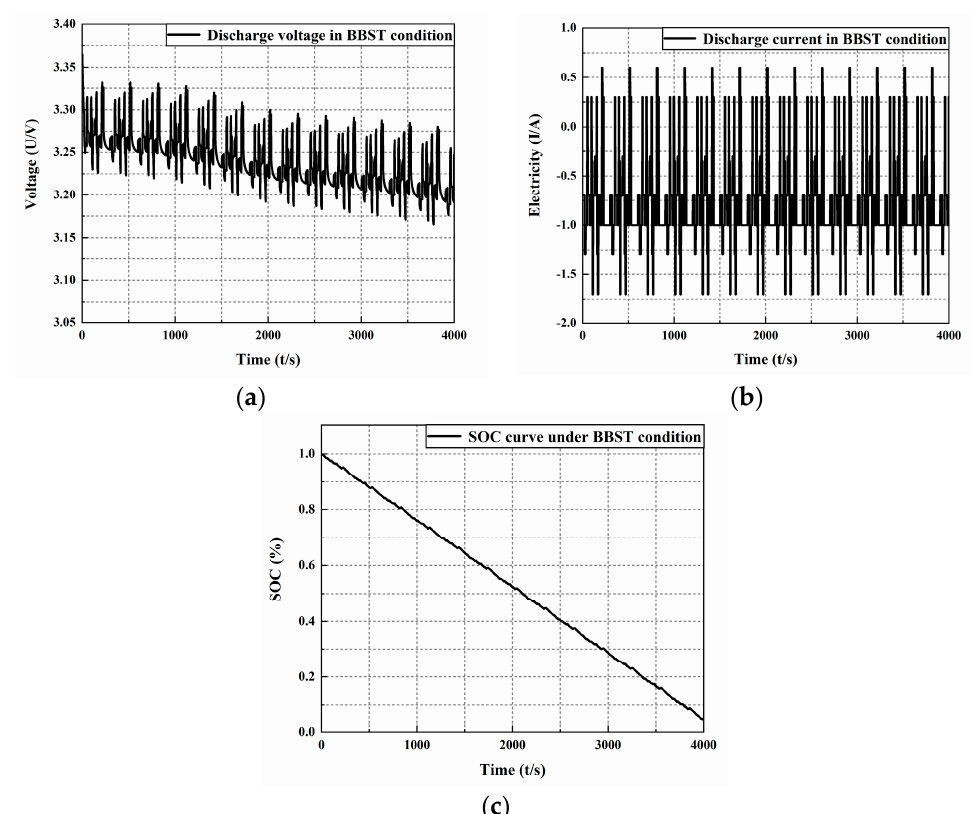
Figure 10. Battery discharge current, terminal voltage, and SOC under BBST conditions. ( a ) Battery discharge current under BBST conditions. ( b ) Battery terminal voltage under BBST conditions. ( c ) Battery SOC under BBST conditions.